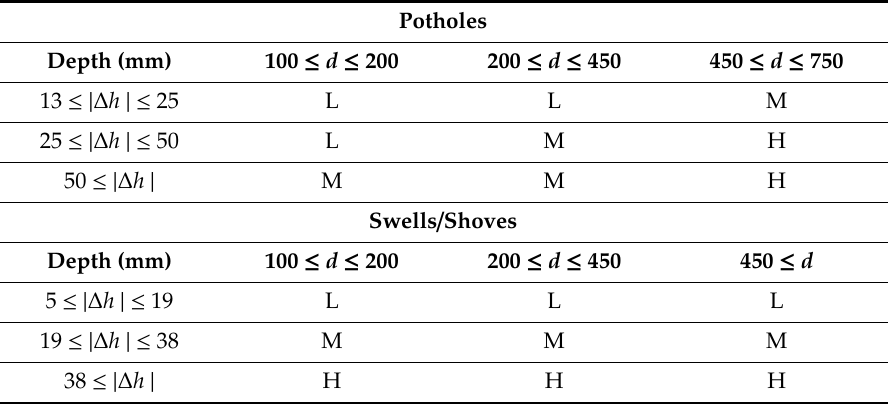
Table 2. Severity levels of distress as a function of the mean diameter ( d ) and depth.